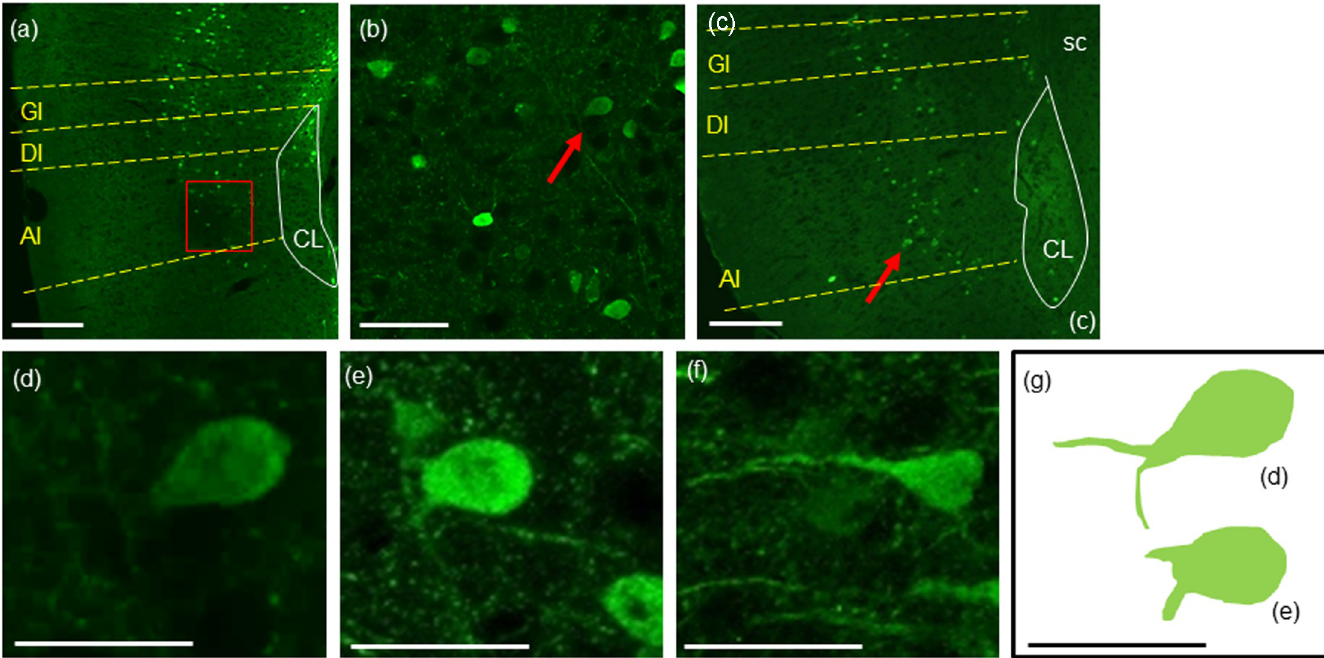
Fig 3. A few Fezf2-positive neurons in the mouse insular cortex exhibited fork cell-like shape by immunofluorescence staining. Immunofluorescence against RFP was performed to visualize Fezf2 signals with frozen brain sections of Tg(Fezf2-tdTomato) mouse. (a)—(c) Fezf2 was expressed in layer Ⅴ and Ⅵ . (b) High magnification image of the red squared box in (a). (d) A fork cell-like neuron indicated by the red arrow in (b), which had two apical dendrites. (e) A fork cell-like neuron indicated by the red arrow in (c). (f) A typical pyramidal neuron in (c). No VEN-like shaped (bipolar) cells were found in the mouse insular cortex. (g) A depicted image of neurons in (d) and (e). Scale bars (a), (c): 200 μ m, (b): 100 μ m, (d)—(g) 20 μ m.